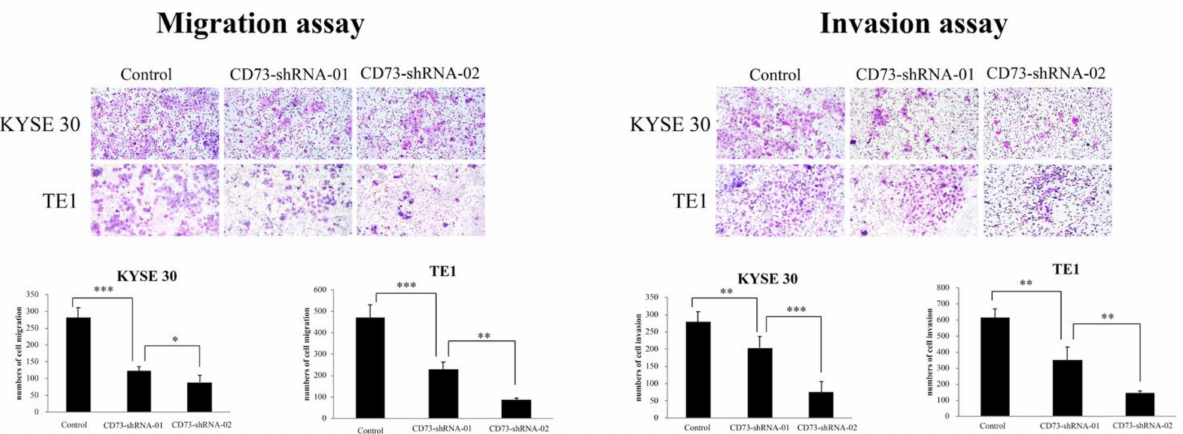
Figure 4. Transwell migration and invasion assays using TE1 and KYSE30 cell lines treated with the CD73-short hairpin RNA (shRNA). Columns, mean; bars, standard deviation. Significant difference: * p < 0.05, ** p < 0.01, and *** p < 0.001.